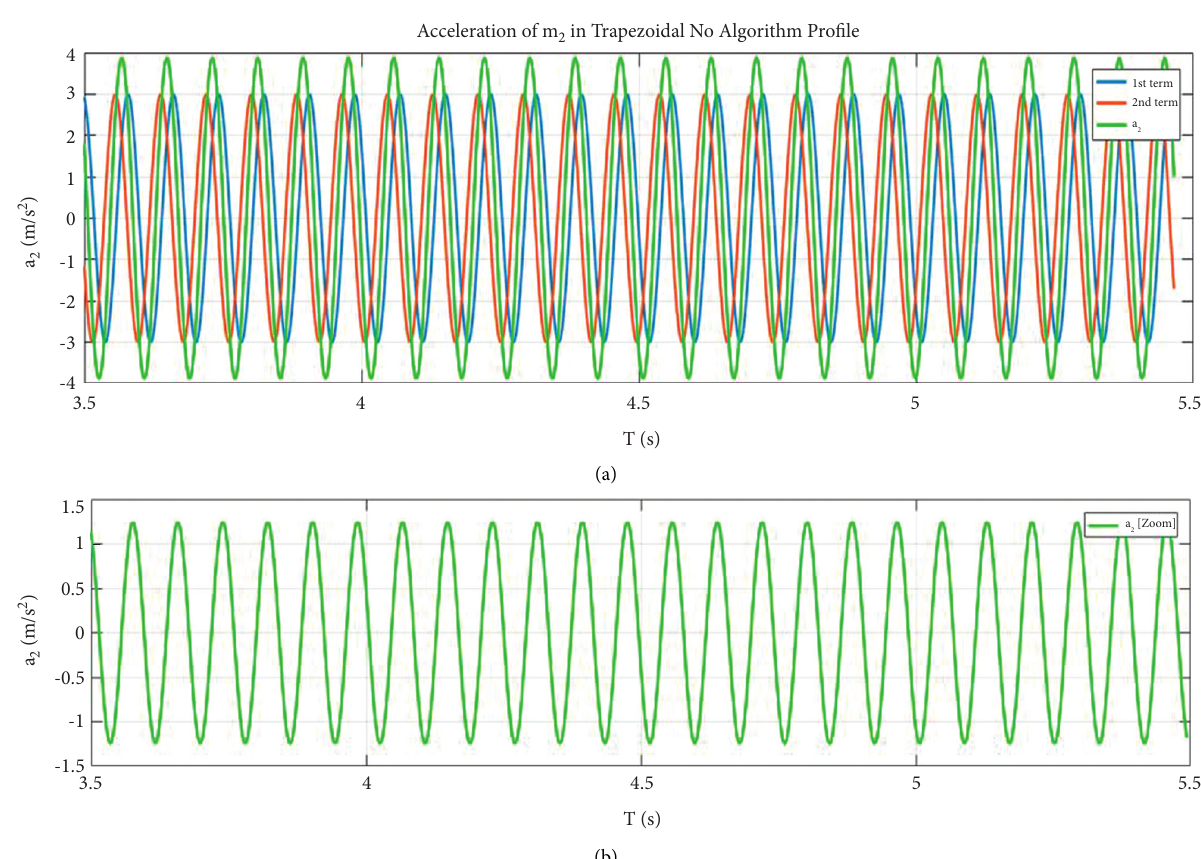
Figure 9: Simulation of the vibration suppression of m term, green: m 2